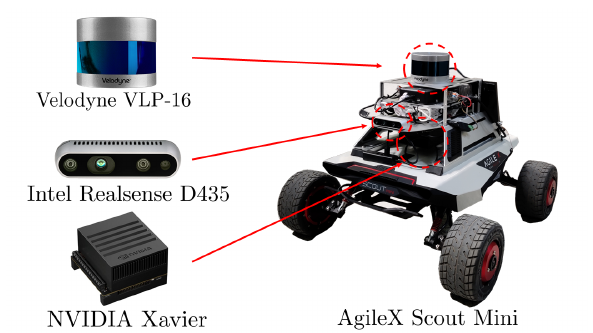
Figure 6. Mobile robotic platform equipped with 3D laser scanner, RGB camera and onboard